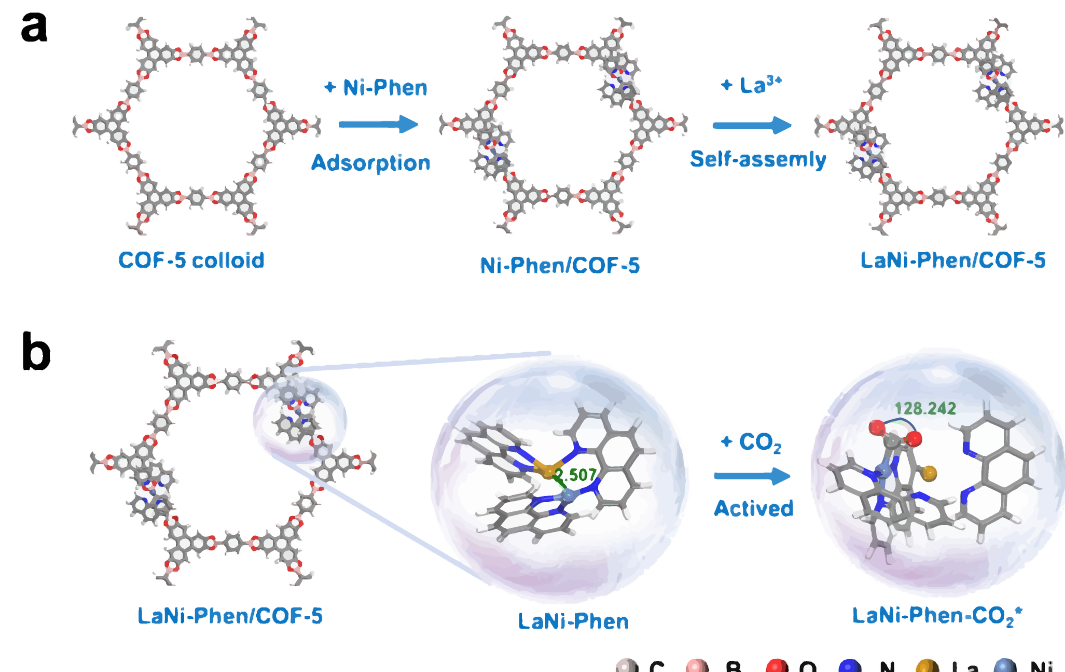
Fig. 1 | Schematic illustration of the construction of the diatomic sites and CO 2 RR.a Self-assemblyofLaNi-Phen into COF-5 colloid to create the diatomicsite photocatalyst. b Schematic diagram of the photocatalytic CO 2 reduction in LaNi-